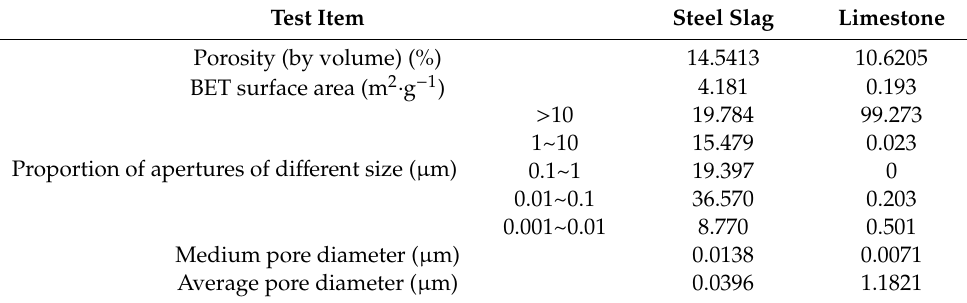
Table 4. Mercury intrusion porosimetry test of steel slag and limestone.